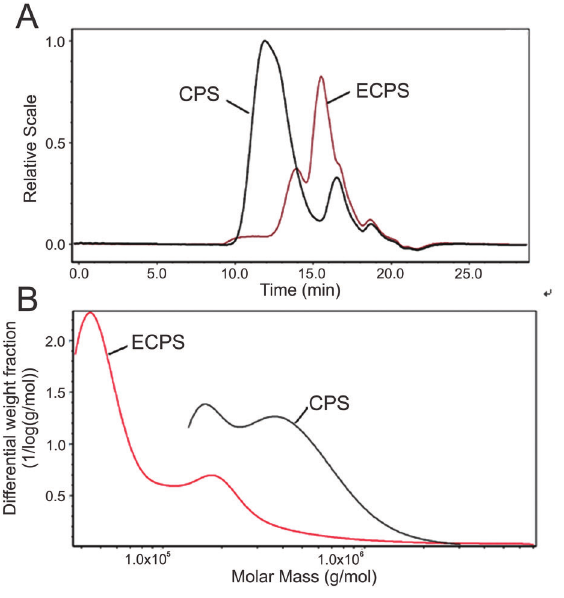
Figure 1. SEC-MALLS-relative intensity result for enzymatically hydrolyzed Cuscuta chinensis polysaccharides (ECPS) and Cuscuta chinensis polysaccharides (CPS) dissolved in 0.1 M sodium chloride solution at 24°C. A , Relative intensity. B , Molar mass